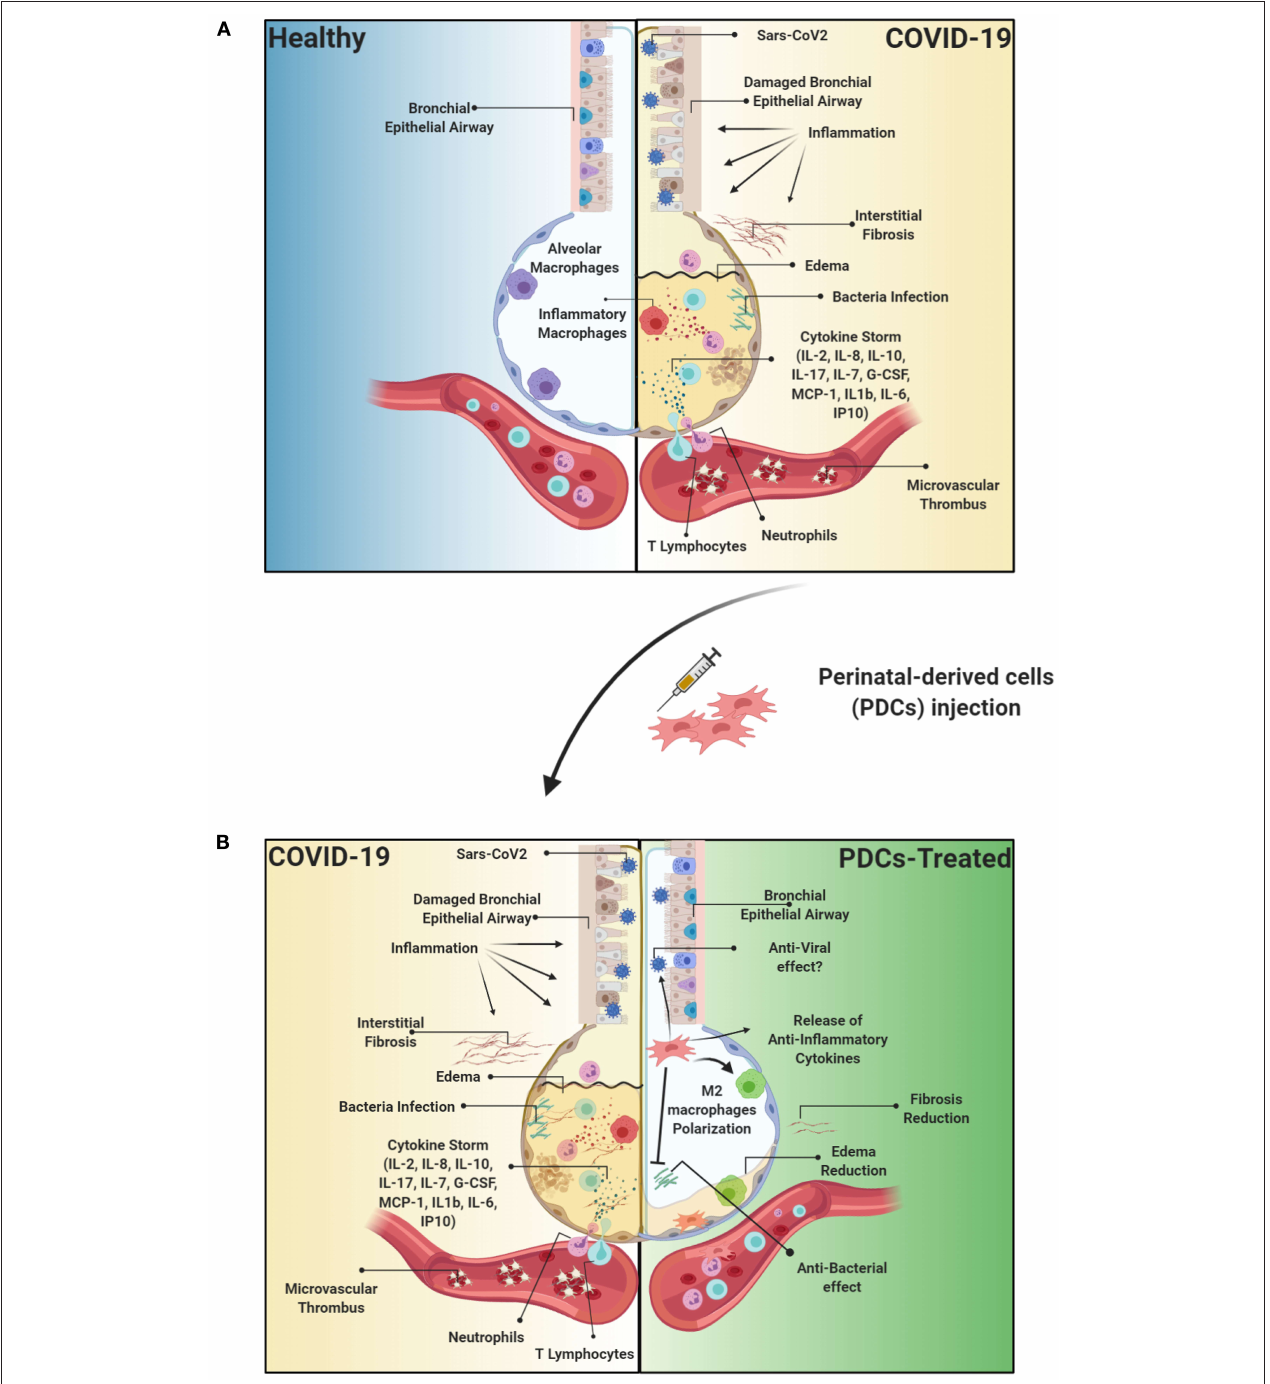
FIGURE 2 | Etiopathology of the Sars-CoV2 viral infection and therapeutic effect of PDCs injection. (A) Sars-CoV2 is responsible for acute respiratory distress syndrome (ARDS) resulting in thousands of patients requiring intensive care unit (ICU) treatment. Importantly, the virus responsible of trigger an exacerbated immune response, resulting in a cytokine storm, and consequently to the damage of the epithelial airway, followed by lung edema, dysfunction of air exchange and the formation of interstitial fibrosis, thus creating an environment conducive to opportunistic bacterial infections or superinfection. Furthermore, COVID-19 is characterized also by the formation of vascular microthrombi that are often identified in areas of diffuse alveolar damage and are associated with diffuse endothelial damage. (B) PDCs treatment can directly affect the immune response through the release of immunomodulatory cytokines, such as IL-10, or anti-inflammatory molecules such as Prostaglandin (PG) E2, thus immunomodulating the exacerbated inflammatory response. Furthermore, MSCs can exert beneficial properties through the release of anti-microbial peptides such as LL-37. Moreover, PDCs can degrade or inhibit ARDS-induced fibrotic tissue by remodeling the extracellular matrix through the release of metalloprotease and TIMP, and modulation of the immune response can consequently reduce the formation of microthrombi affecting the alveolar capillaries. Created with Biorender.com.